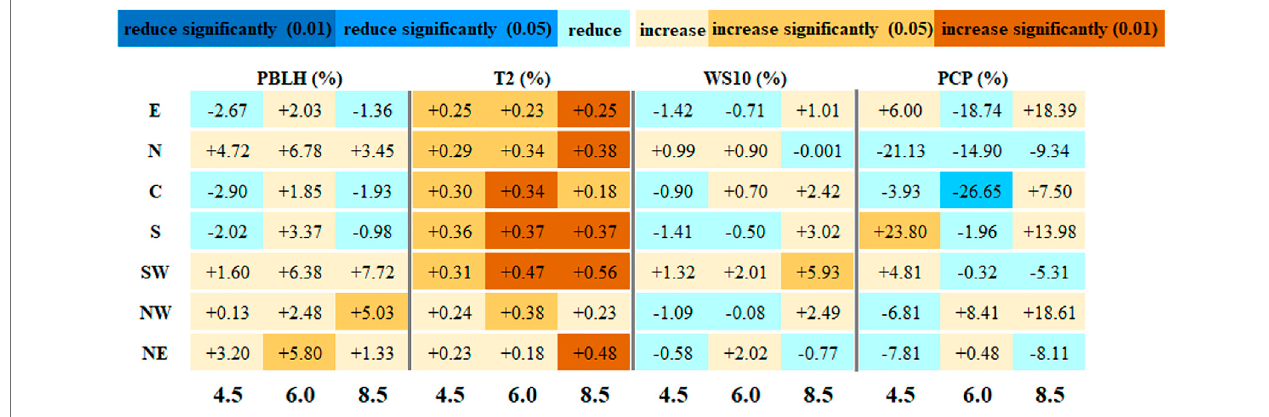
FIGURE 4 | The relative changes (2046 – 2055 relative to 2006 – 2015) in meteorological fi elds for different regions of China. Statistical signi fi cance is marked with